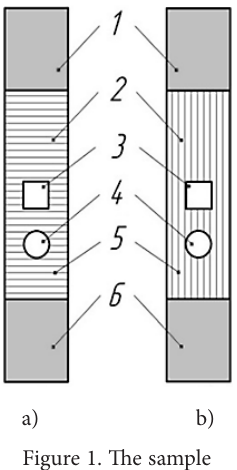
Figure 1. The sample The first group included samples (Figure 1) on epoxy matrix (cut with a water-abrasive stream, not with pla- sma: Nowakowski & Wijas, 2016) with a transverse ar- rangement of the base fibers relative to the applied force (Figure 1a); the second group included the same samples, but with a longitudinal orientation of the base fibers rela- tive to the same applied force (Figure 1b). In addition, the second group of samples made of fiberglass also included a group of samples made of carbon fiber (on epoxy ma- trix). The samples (cut according to the standard DIN- EN ISO 527: length 250 mm, width 25 mm and thickness from 1.92 ± 0.1 mm to 2.2 ± 0.02 mm – Figure 1) were rectangular plates 2 with plates 1 and 6 fixed to the upper